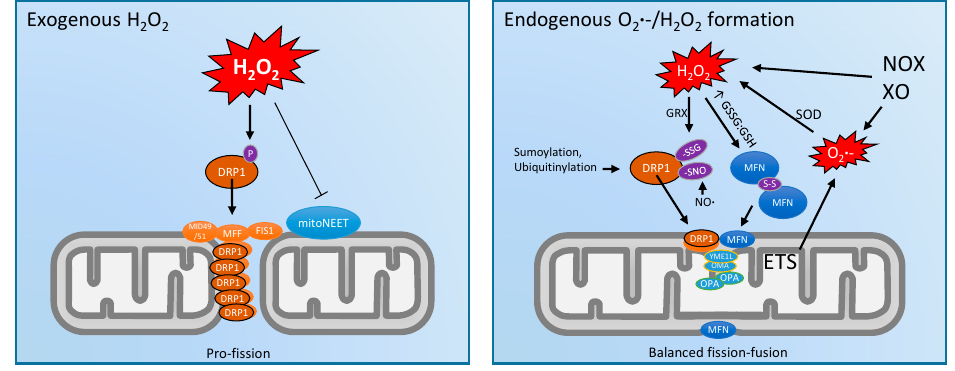
Figure 2. Regulatory responses of mitochondrial dynamics machinery to exogenous vs. endogenous reactive oxygen species (ROS) in the form of superoxide (O 2 • − ) and/or hydrogen peroxide (H 2 O 2 ). Exogenous H 2 O 2 application (often used experimentally at supraphysiologic concentrations) leads to fragmentation via the activation of DRP1 via phosphorylation at Ser616 and also a mitoNEET dependent mechanism. Endogenous ROS generated in specific microdomains such as sites within the electron transport system (ETS), NADPH oxidase (NOX) or xanthine oxidase (XO) enzymes target numerous redox active cysteine residues contained within both fission and fusion proteins via S -glutathionylation (protein–SSG), disulfide bond formation (S–S), and S -nitrosation (protein–SNO) post-translational modifications. This allows precise control of mitochondrial dynamics in response to spatial and temporal changes in ROS. GSSG: oxidized glutathione; GSH: reduced glutathione; GRX: glutaredoxin; SOD: superoxide